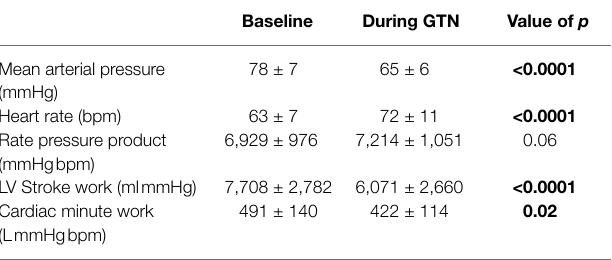
TABLE 3 | Hemodynamic values at rest and during GTN infusion (values averaged over 5